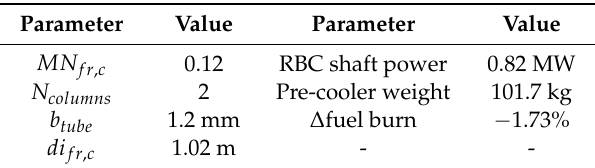
Table 9. Parameters of the final pre-cooler design at cruise.